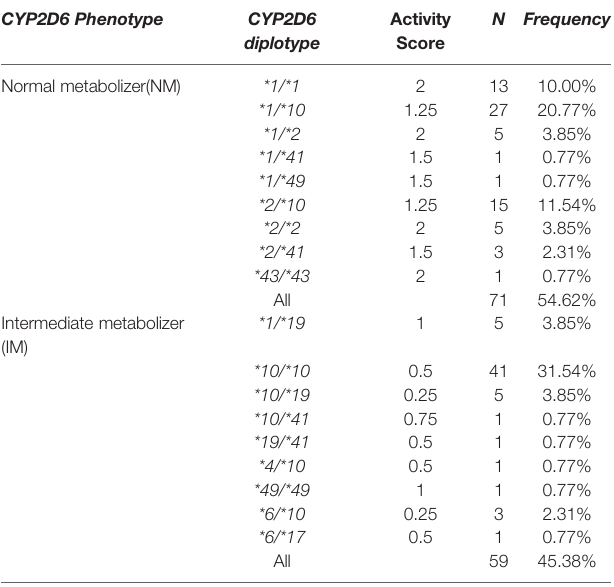
TABLE 2 | Frequencies of CYP2D6 phenotypes and corresponding CYP2D6 diplotypes identi fi ed in the present study. CYP2D6 Phenotype